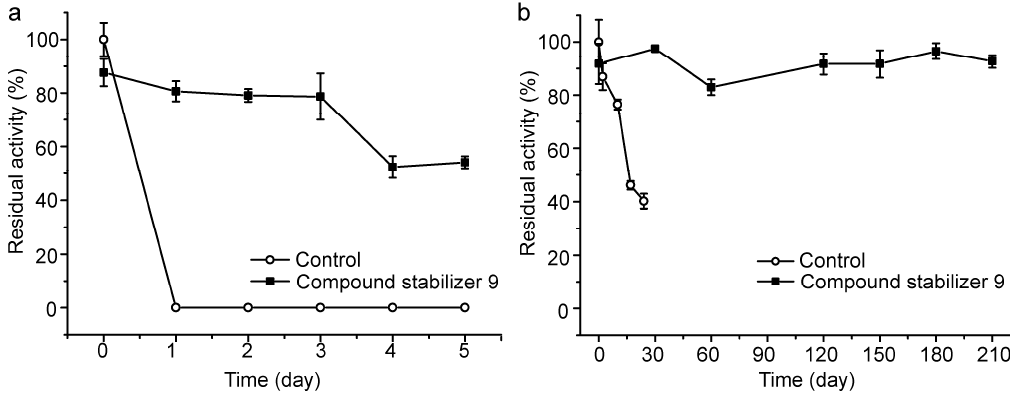
Figure 6. Thermostability of pseudoalterin preserved in compound stabilizer 9 at 37 ◦ C ( a ) and 4 ◦ C ( b ). The enzyme solution was mixed with compound stabilizer 9 and incubated at 37 ◦ C for 5 days and at 4 ◦ C for 210 days. The enzyme solution in 50 mM Tris-HCl (pH 9.0) served as the control. The activity of the enzyme solution in 50 mM Tris-HCl (pH 9.0) before incubation was taken as 100%. Experiments were performed in triplicate, and error bars indicate standard deviation.